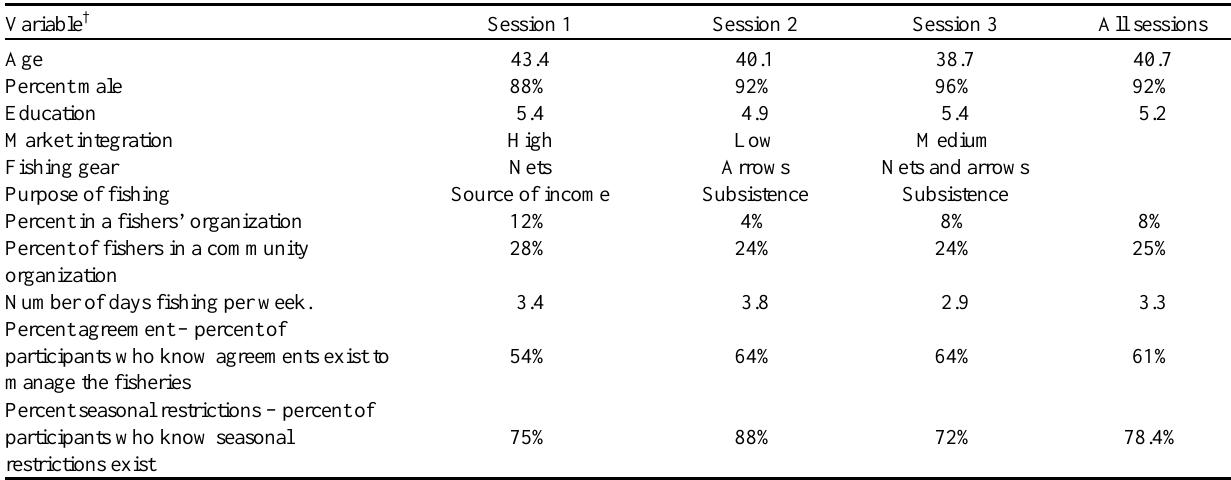
Table 1 . Participants´ sociodemographic